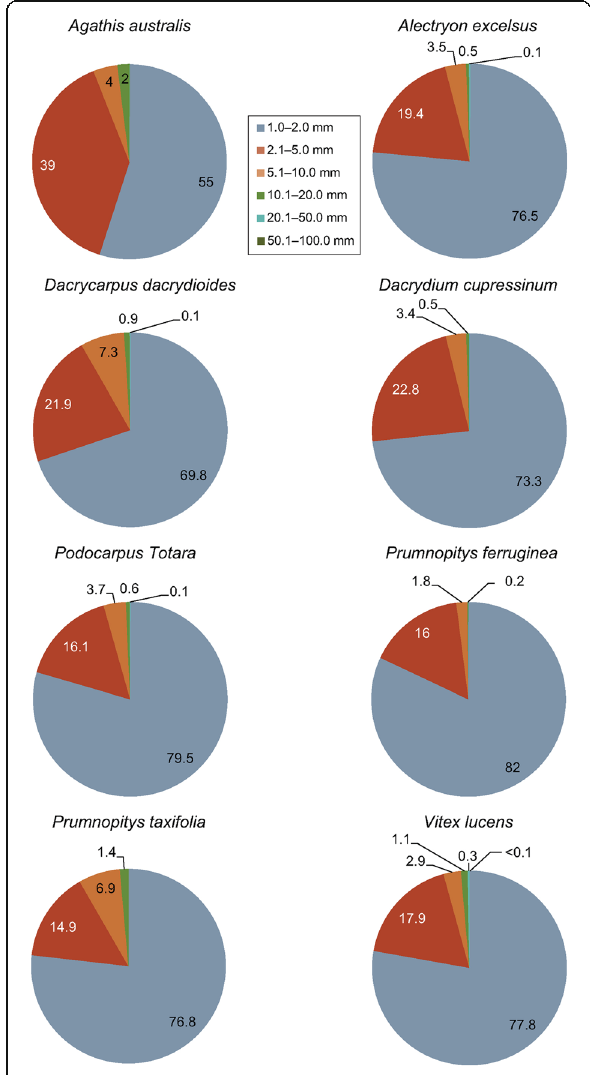
Fig. 12 Percent root length (%) by diameter size class (mm) of 5-year-old